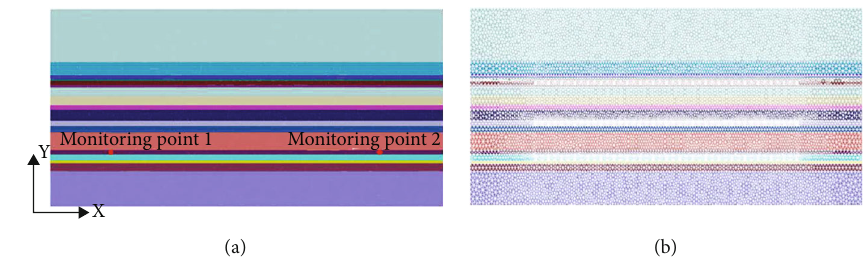
Figure 6: Model overview: (a) numerical model; (b)